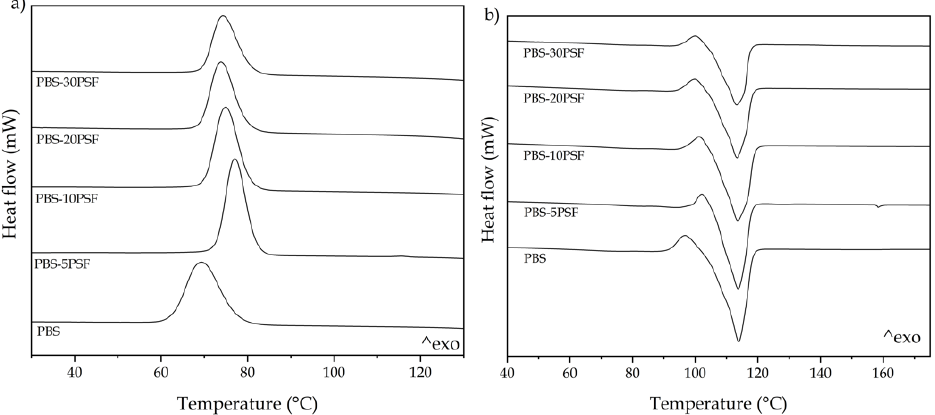
Figure 6. Differential scanning calorimetry (DSC) thermograms taken during cooling ( a ) and second heating ( b ) of the injection-molded pieces of poly(butylene succinate) (PBS)/pistachio shell flour (PSF) compatibilized with poly(butylene succinate) grafted with maleic anhydride (PBS- g -MAH). Table 3. Main thermal parameters of the injection-molded pieces of poly(butylene succinate) (PBS)/pistachio shell flour (PSF) compatibilized with poly(butylene succinate) grafted with maleic anhydride (PBS- g -MAH) in terms of crystallization temperature (T c ), crystallization enthalpy ( ∆ H c ), cold crystallization temperature (T cc ), cold crystallization enthalpy ( ∆ H cc ), melting temperature (T m ), melting enthalpy ( ∆ H m ), and crystallinity degree (X c ).